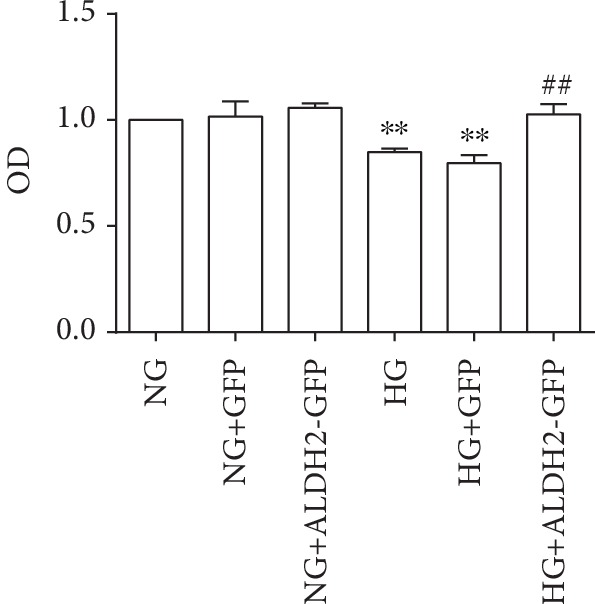
The cell viability of H9C2 cardiac cells in the different groups (mean ± SD, n = 5). ∗∗P < 0.01vs. NG; ##P < 0.01vs. HG and HG+GFP.